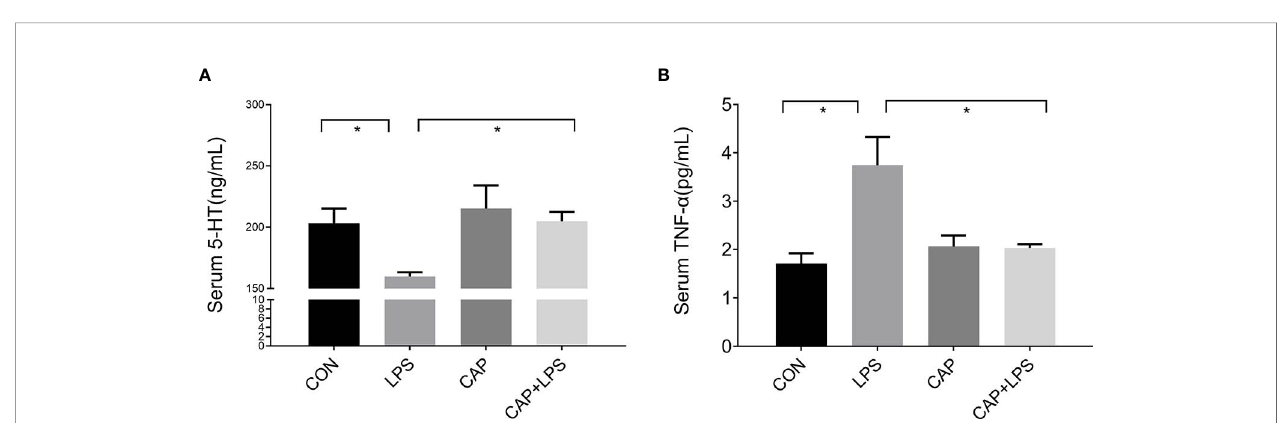
FIGURE 3 | Dietary CAP prevented alterations in serum 5-HT and TNF- a levels in LPS-treated mice. (A) 5-HT (F 3,16 = 4.259, P < 0.05). (B) TNF- a (F 3,20 = 7.436, P < 0.01). Data are represented as mean ± SEM (n = 5). Asterisk has been used for signi fi cant differences (*P < 0.05).